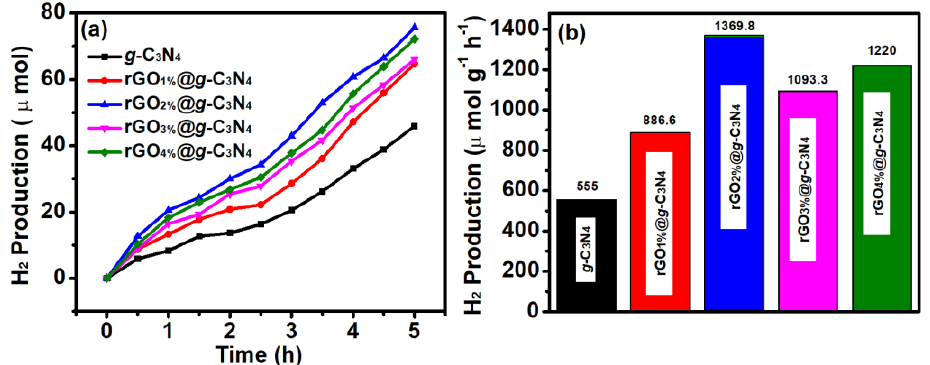
Figure 9. ( a ) H 2 production and ( b ) H 2 production rate per hour under the same experimental